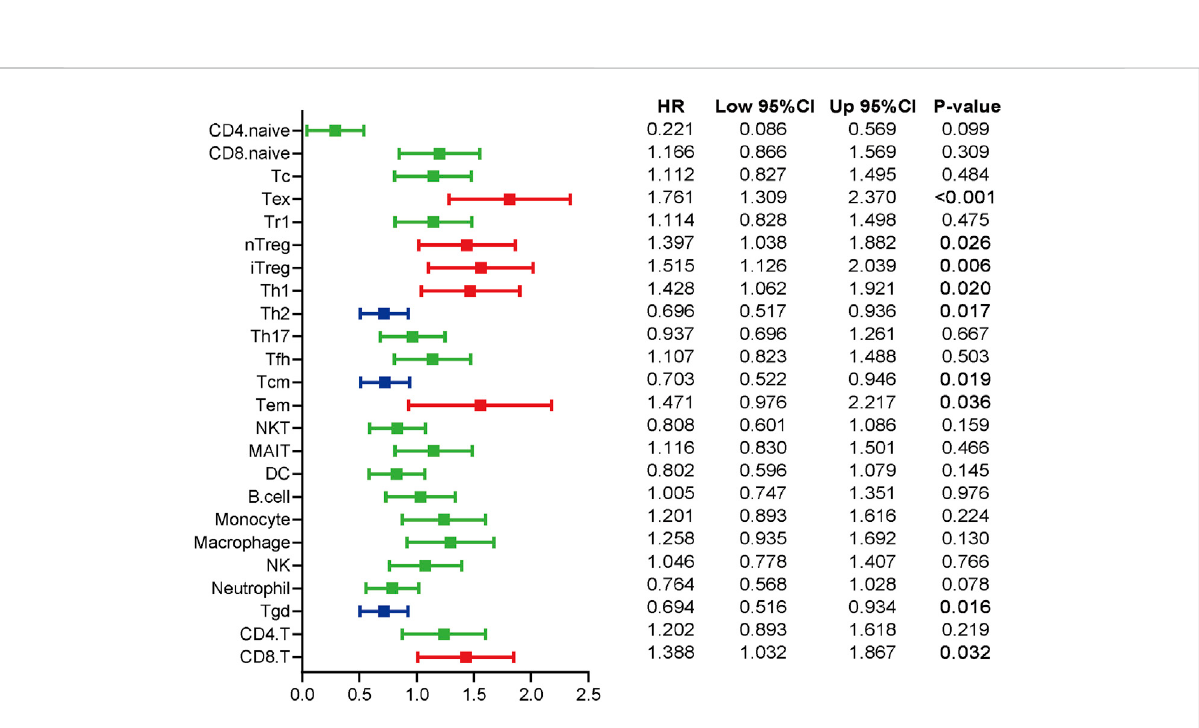
FIGURE 4 The prognostic values of TIICs in ccRCC patients. Overview of Kaplan-Meier analysis for the prognostic values of 24 TIICs in ccRCC. Red represents risky factor, and blue represents protective factor. Signi fi cance was calculated with log-rank